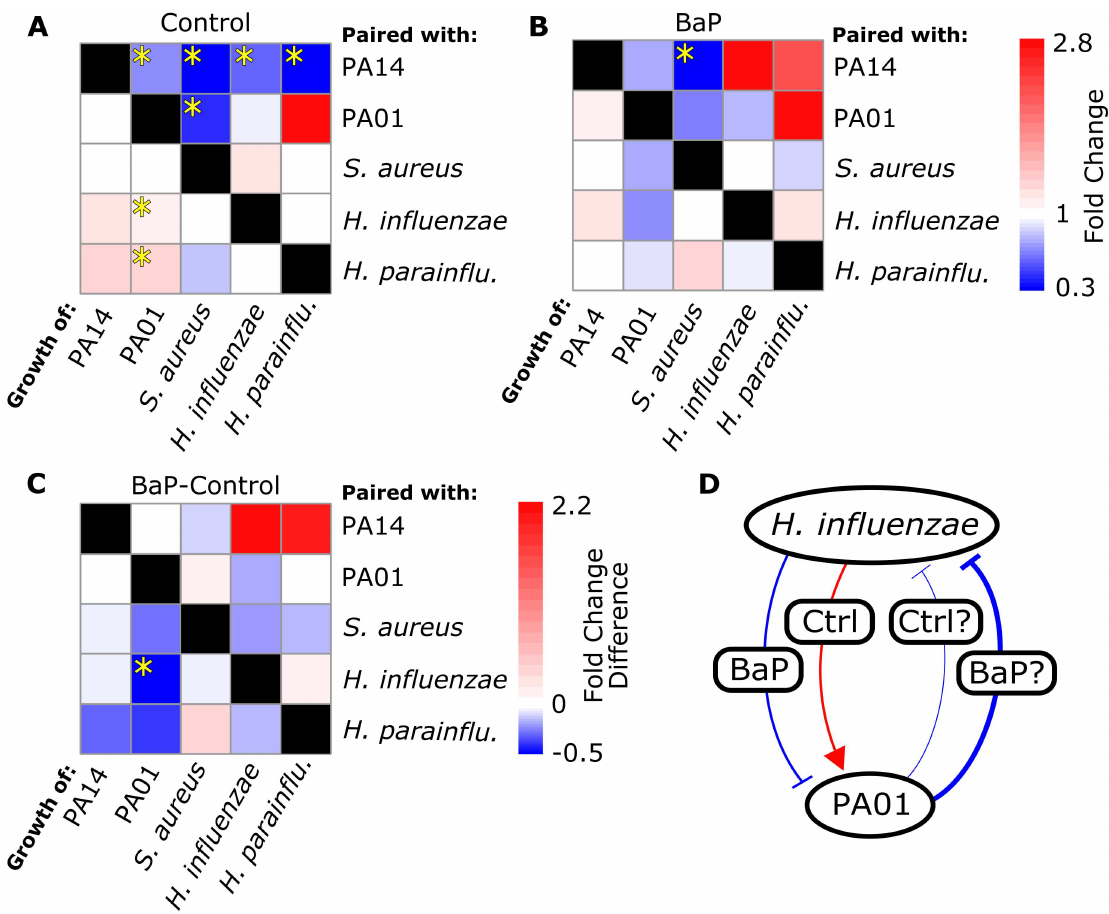
Fig 4. Interactions between species are context-dependent. A—B Heat maps indicatethe fold change in colony area during pairwisegrowth with respect to growth alone. Fold changesin colony area are shown for the species in the columns. The species along the rows are those which influencedthe growth of the speciesin the columns. Statistically significantchangesin colony areas are indicatedby yellow stars (p-value < 0.05 by two-sidedWilcoxon signed-rank test corrected by FDR). A . Fold changesin colony area in control media. S . aureus grows significantly less when grown next to P . aeruginosa PA01, and P . aeruginosa PA01 grows significantly less when pairedwith P . aeruginosa PA14. B . Fold changesin colony area in BaP media. Only one interaction is statistically significantin this context, and it is an interaction that was also observedin the control condition. C . Panel A subtracted from panel B. The difference in fold change is an indicationof how different the interactions are in the two conditions. Statistical significancewas determined by two-sidedWilcoxon signed-rank test on the fold changedata for each interaction, and then FDR corrected. Only one interactionwas significantly changedbetweenthe two conditions. P . aeruginosa PA01 grew more when pairedwith H . influenzae in control media, but grew less in BaP media. Some interactions were essentiallyidentical betweenthe two conditions (e.g. P . aeruginosa PA01 grows less when pairedwith P . aeruginosa PA14, regardlessof the presenceof BaP), and others were changed,if not in a statistically significantway (e.g. P . aeruginosa PA01 grows more when pairedwith H . parainfluenzae in control media, but less in BaP media). D . An illustrationof the BaP-dependent interactions between H . influenzae and P . aeruginosa PA01. We put question marks besidethe interactionswhich are observed but not statistically significant.Note the representation of the hypothesisthat BaP causes H . influenzae to switch from a positive to a negativeinfluenceon P . aeruginosa